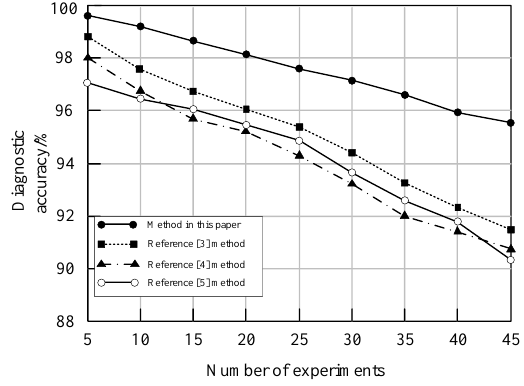
Figure 4. Comparison of the diagnostic accuracy of each diagnostic method